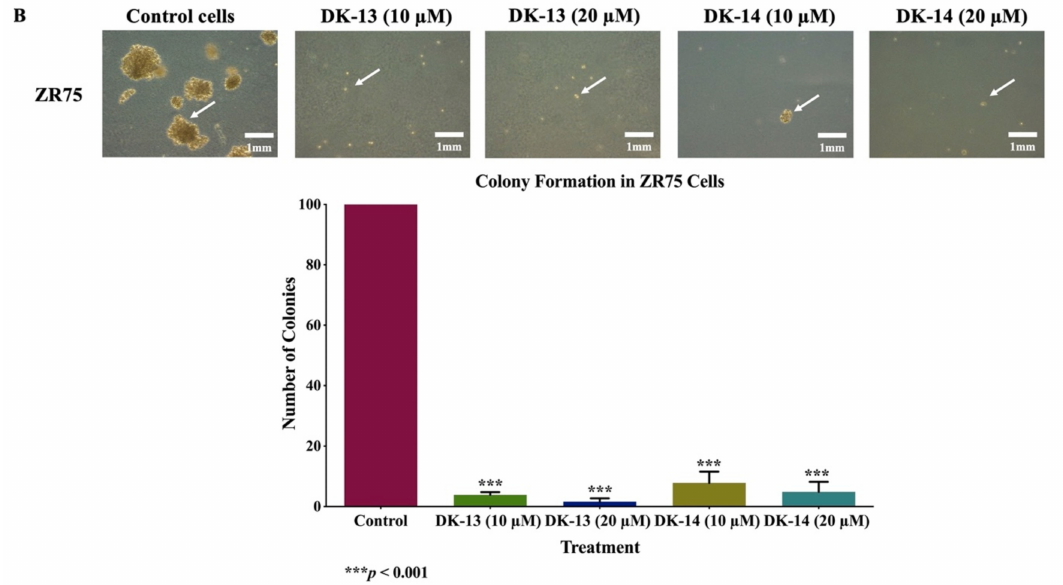
Figure 5. ( A , B ). Effect of chalcone compounds (DK-13 and -14) on colony formation, in soft agar, in human HER2-positive cancer cell lines, ( A ) SKBR3 and ( B ) ZR75. The compounds inhibit colony formation of SKBR3 and ZR75, in comparison with their matched control cells; as marked by the white arrows ( × 10 magnification). The colonies were counted manually and expressed as percentage of treatment relative to the control (mean ± SEM).